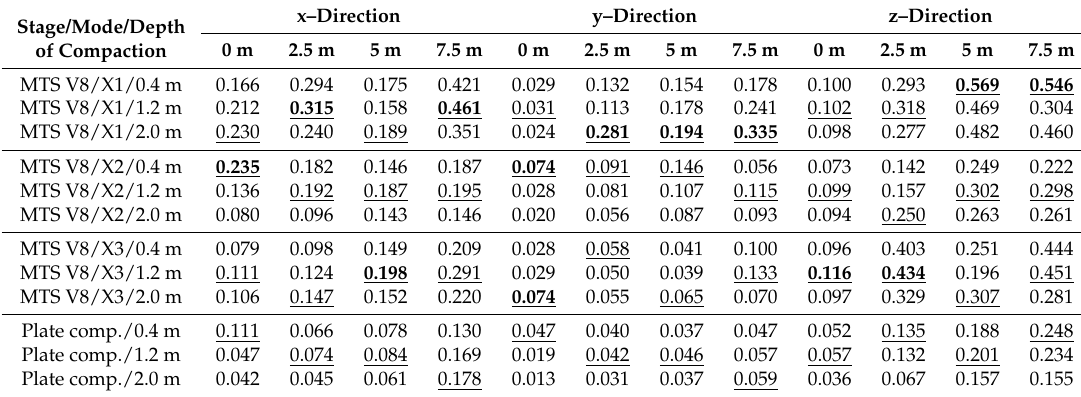
Table 2. Summary of PPAs—stage I (source of vibration Ls = 15 m), m/s 2 .